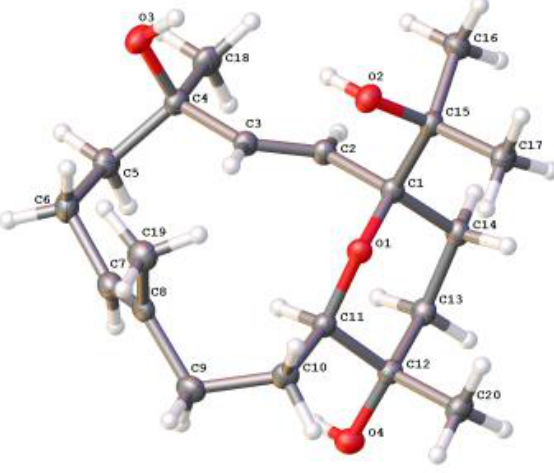
Figure 5. Perspective ORTEP drawings of X-ray structures of compound 4 . Sarcoxacyclol E ( 5 ) had a molecular formula of C 20 H 34 O 5 deduced from a pseudo- molecular ion peak at m / z 377.2294 ([M+Na] + , calcd. for C 20 H 34 O 5 Na, 377.2298) in the HRESIMS spectrum, requiring four degrees of unsaturation. The 1 H and 13 C NMR data of 5 (Table 2) displayed the signals attributed to one disubstituted double bond [ δ H 5.44 (1H, d, J = 15.9 Hz, H-2), 5.75 (1H, d, J = 15.9 Hz, H-3); δ C 124.1 (CH, C-2), 140.7 (CH, C-3)] and one epoxide group [ δ H 2.89 (1H, d, J = 9.7 Hz, H-7); δ C 66.8 (CH, C-7), 61.9 (qC, C-8)]. These two functionalities accounted for two degrees of unsaturation; the left two indicated that compound 5 was a bicyclic diterpene. The interpretation of its 1 H– 1 H COSY spectrum (Figure 3) disclosed four segments: a . H-2–H-3, b . H 2 -5–H 2 -6–H-7, c . H 2 -9–H 2 -10–H-11, and d . H 2 -13–H 2 -14. The HMBC correlations (Figure 3) from H 3 -18 ( δ H 1.28) to C-3 ( δ C 140.7), C-4 ( δ C 74.0), and C-5 ( δ C 42.4) led to the connection of partial structures a and b via quaternary carbon C-4 bearing a hydroxyl group. The observed HMBC cross-peaks